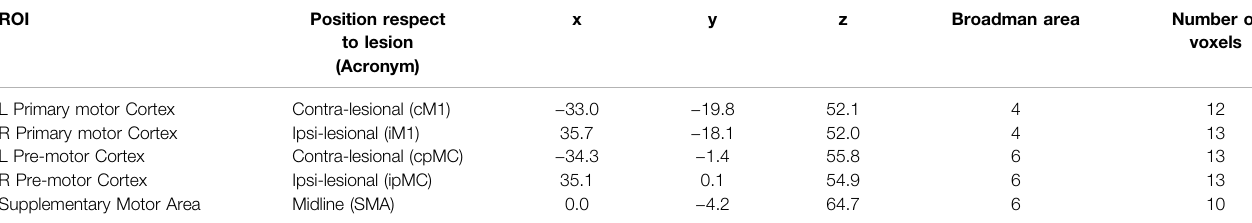
TABLE 2 | Regions of interest (ROIs) centroids coordinates in MNI coordinates system.